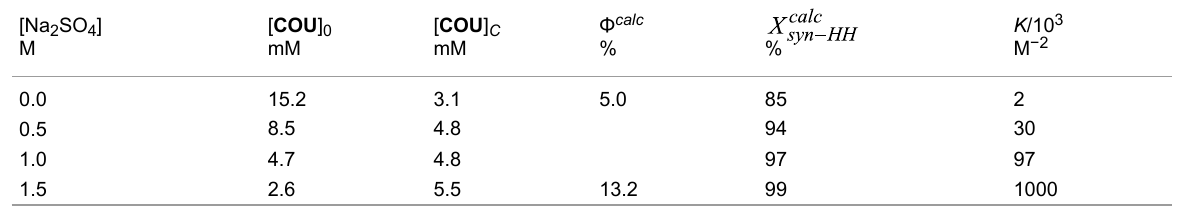
Table 5: The quantum yields, calculated according to (4) and the fractions of the syn -HH dimer, calculated according to (5), for the photodimerization of COU in a 6.0 mM solution of γ -CD thioether 2 and binding constant K as a function of salt concentration.